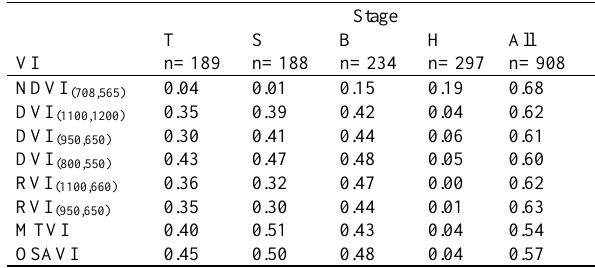
Table 3. Coefficient of determination (R²) for the relationship